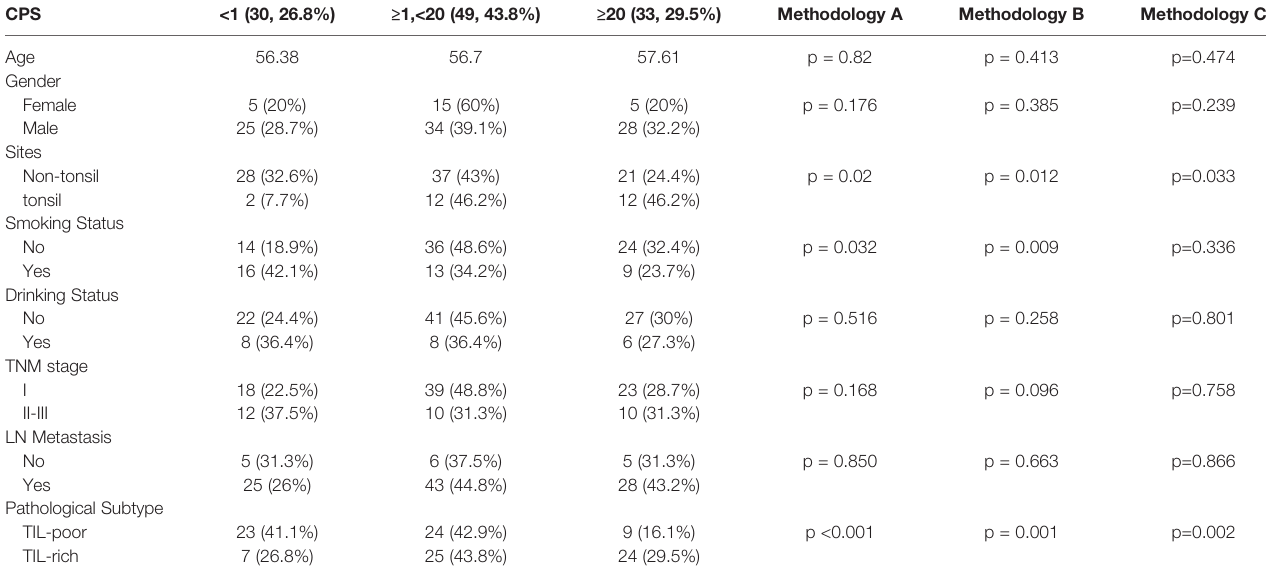
TABLE 1 | Clinical characteristics of HPV (+)OPSCC classi fi ed by PD-L1 expression level. CPS <1 (30, 26.8%) ≥ 1,<20 (49,